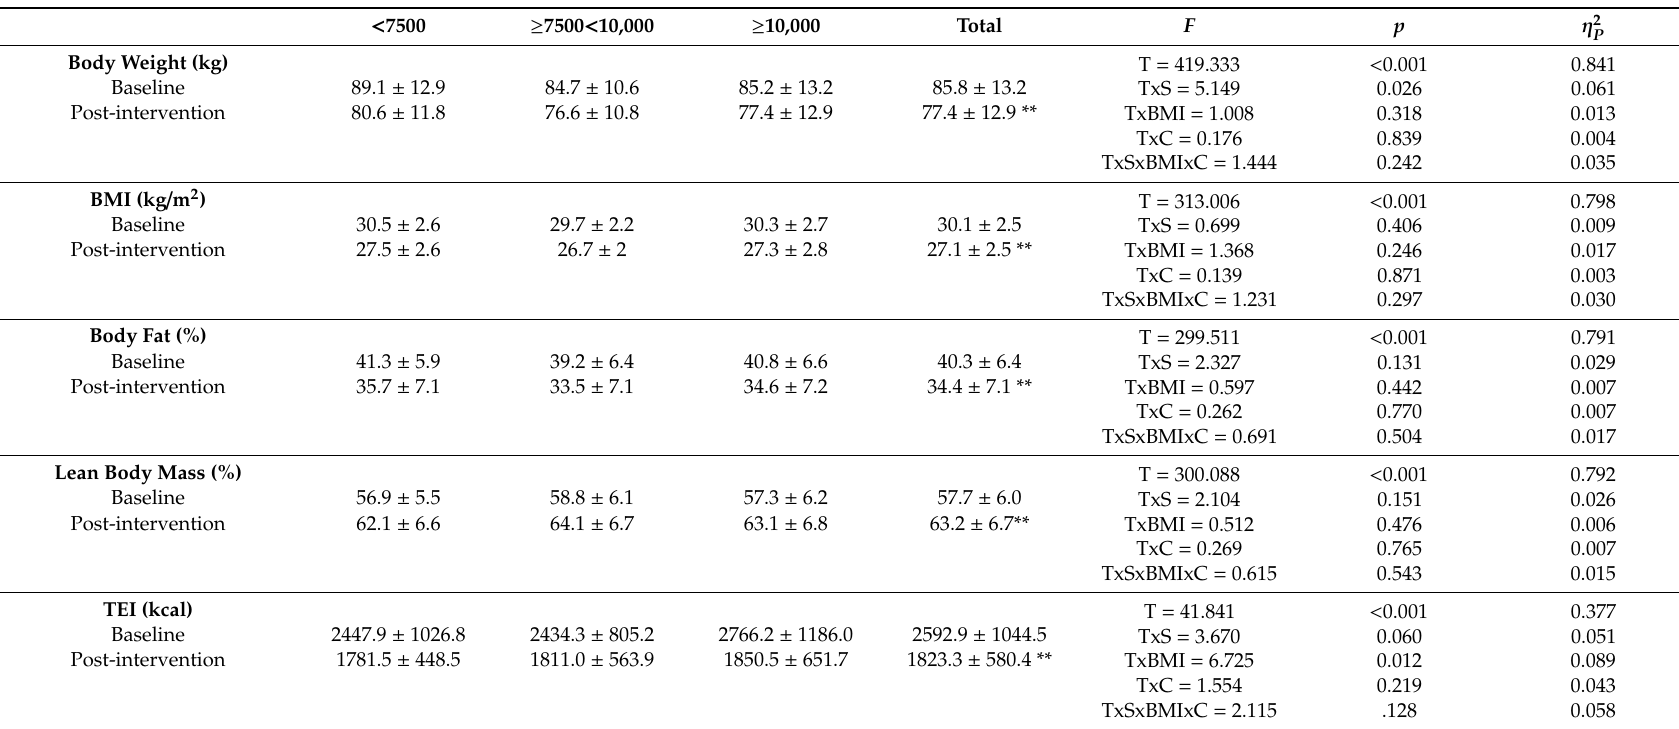
Table 3. Dietary and motivation-related variables by categories of daily steps at